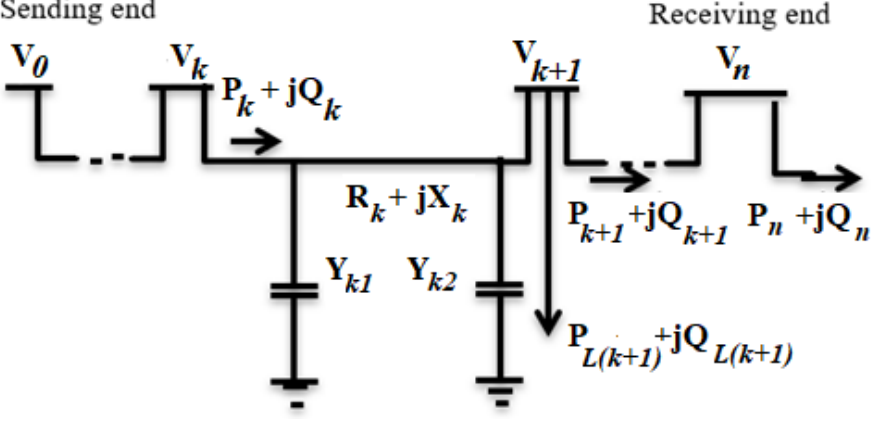
Figure 2. The single-line diagram of a radial system.